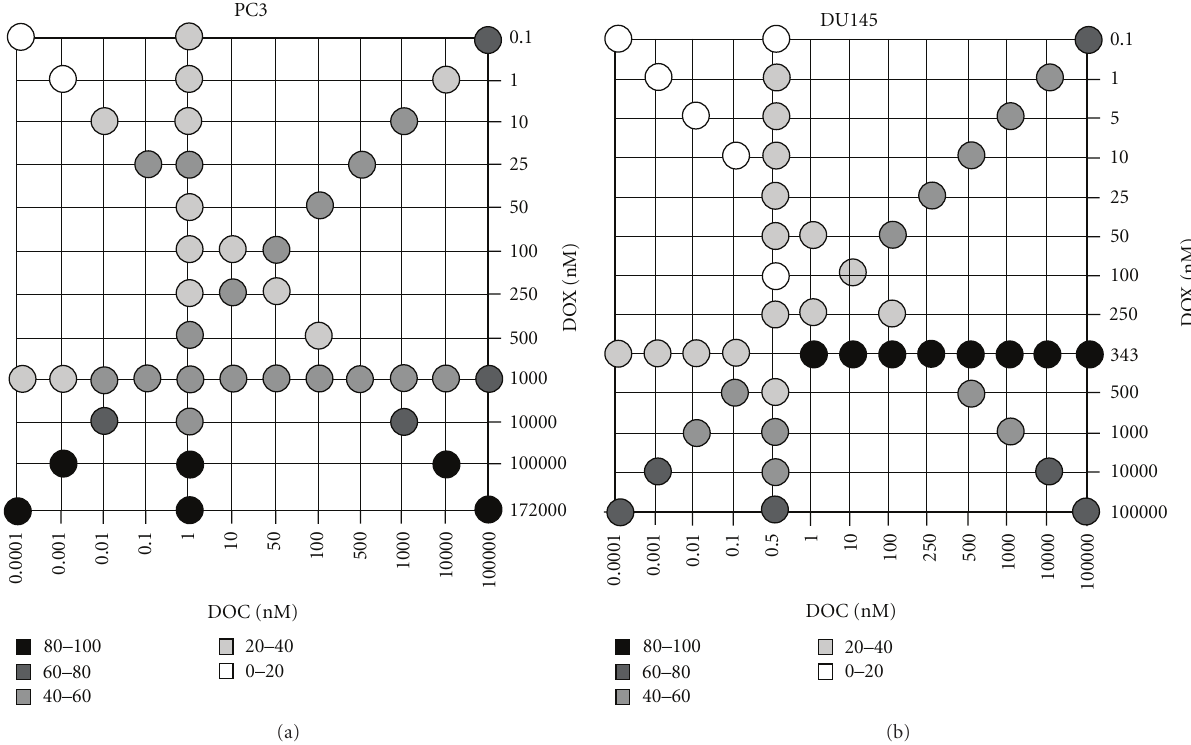
Figure 4: Drug combination cytotoxicity. The grayscale dots in the figure show average percent cell death of PC3 and DU145 cells at each combination setting from triplicate experiments shown in Figure 3.